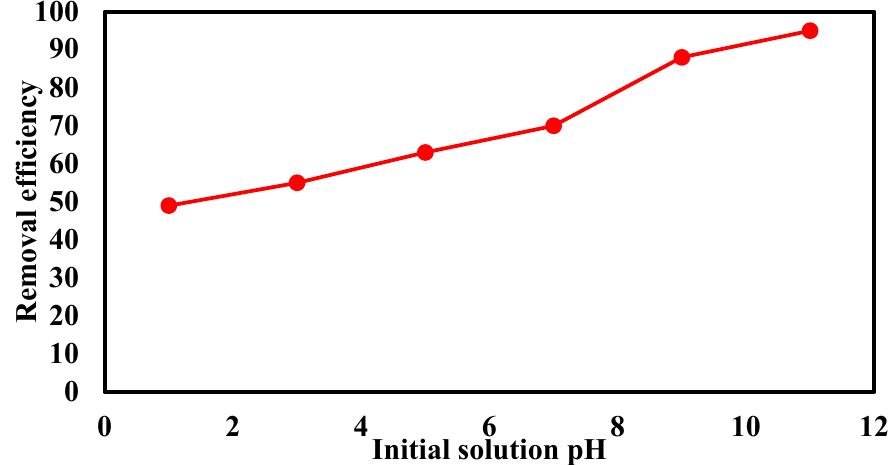
Figure 10. Effect of solution pH on the removal efficiency of trimethoprim antibiotic, contact time of 60 min, and adsorbent dose of 0.5 g/L.